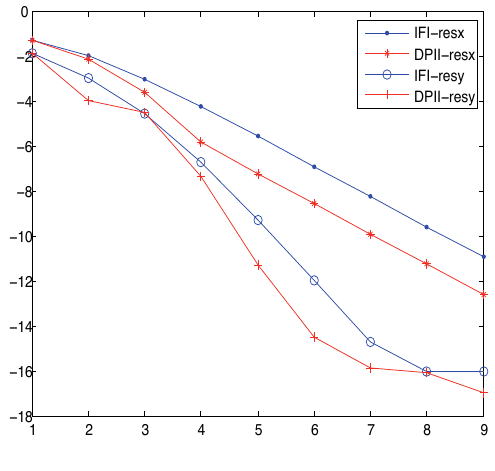
Fig. 1. Residual history for Example 1.